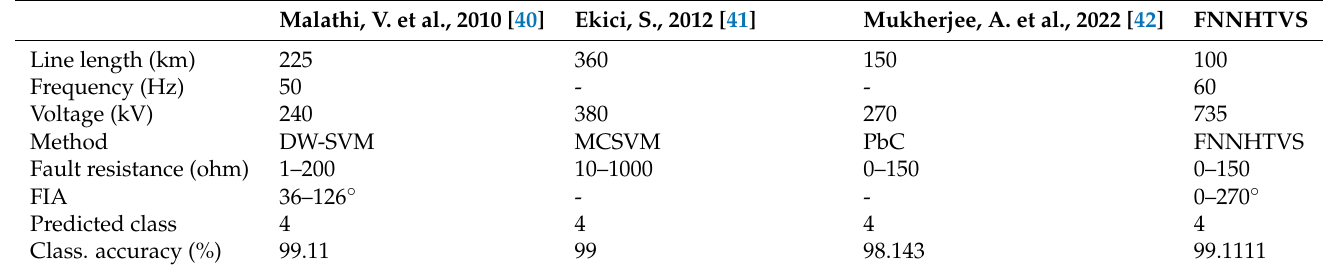
Table 11. Comparative